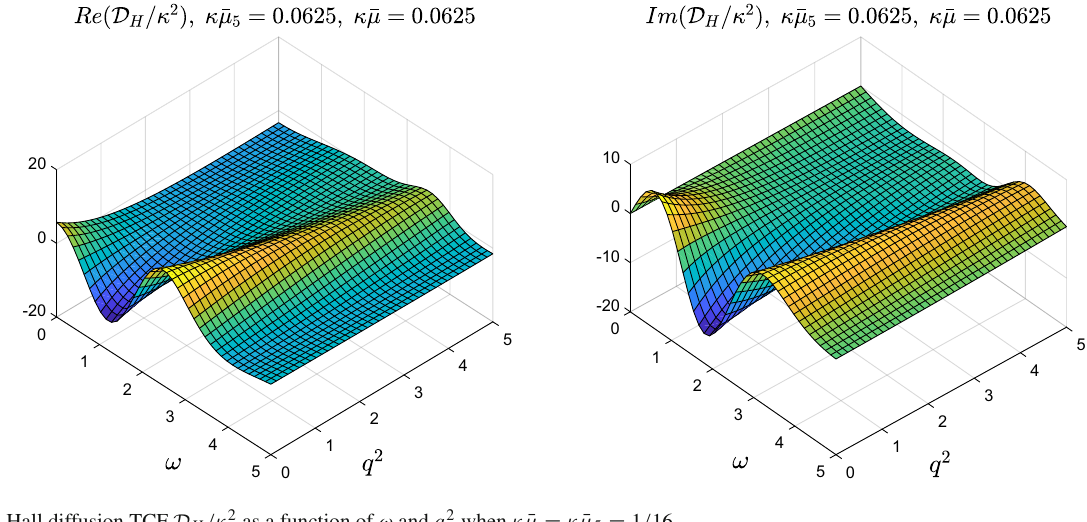
Fig. 4 Hall diffusion TCF D H /κ 2 as a function of ω and q 2 when κ ¯ μ = κ ¯ μ 5 = 1 / 16